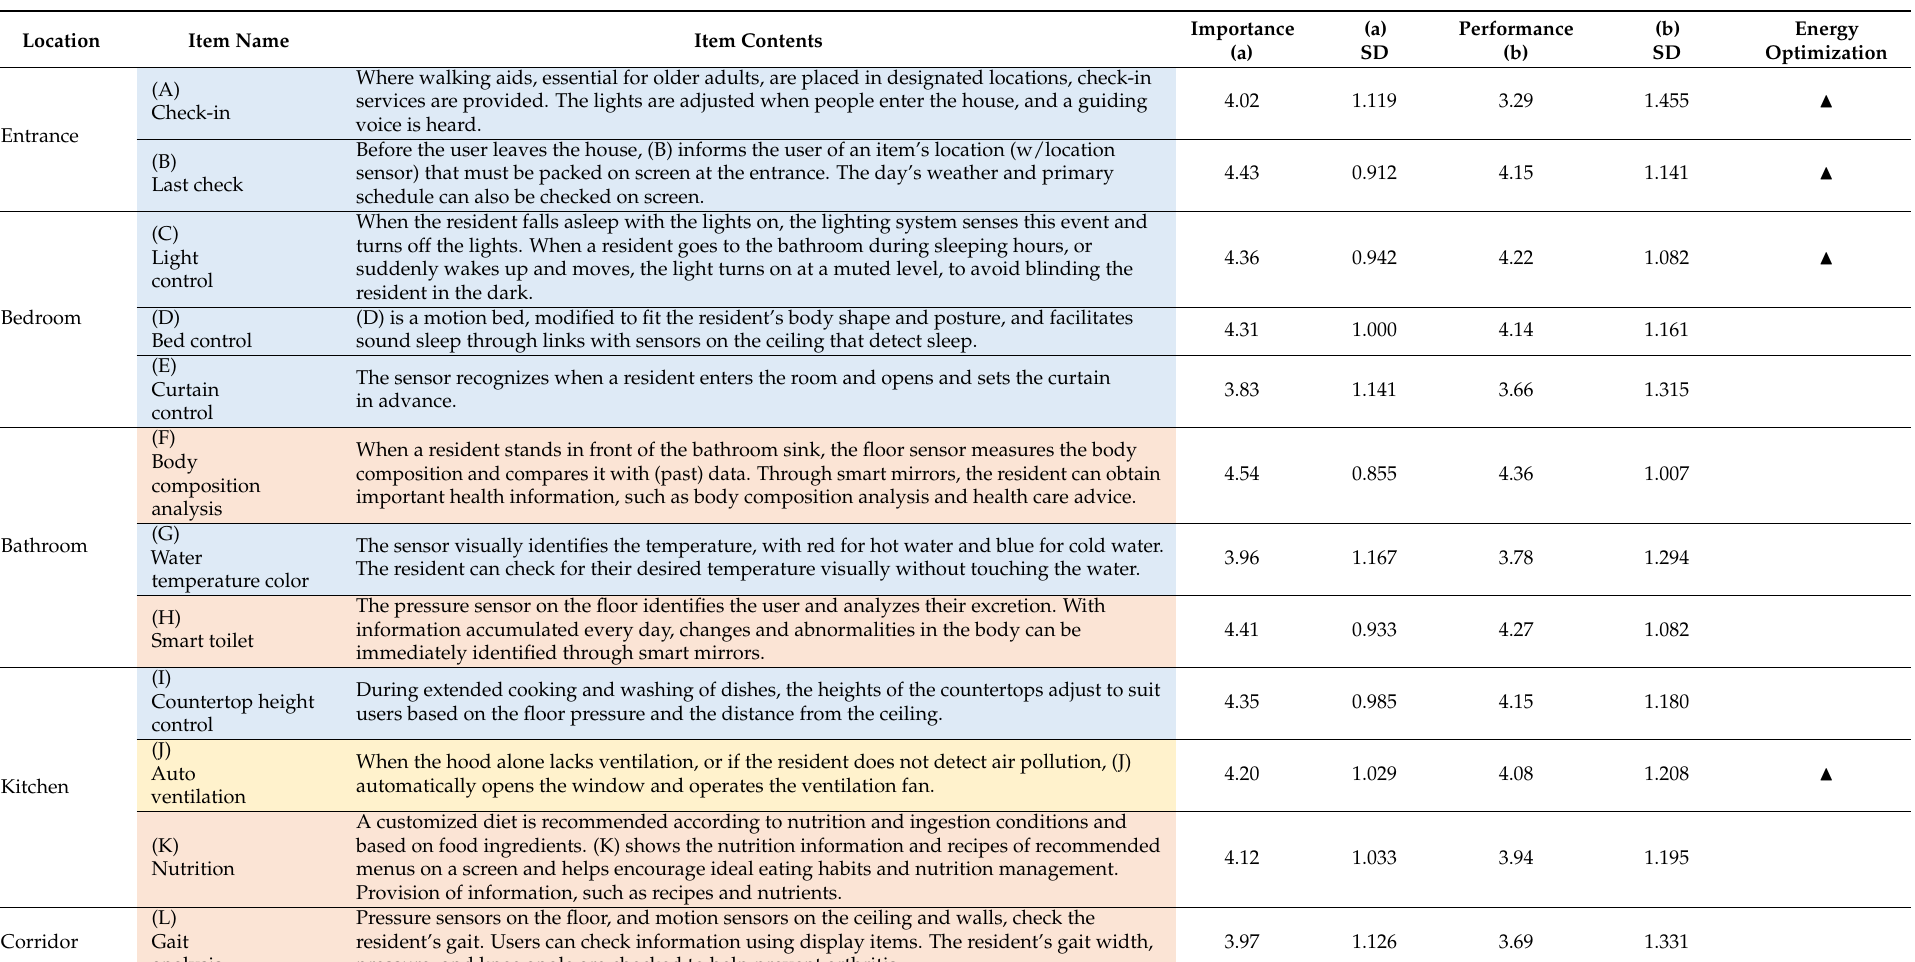
Table 3. Smart items in the smart home living lab